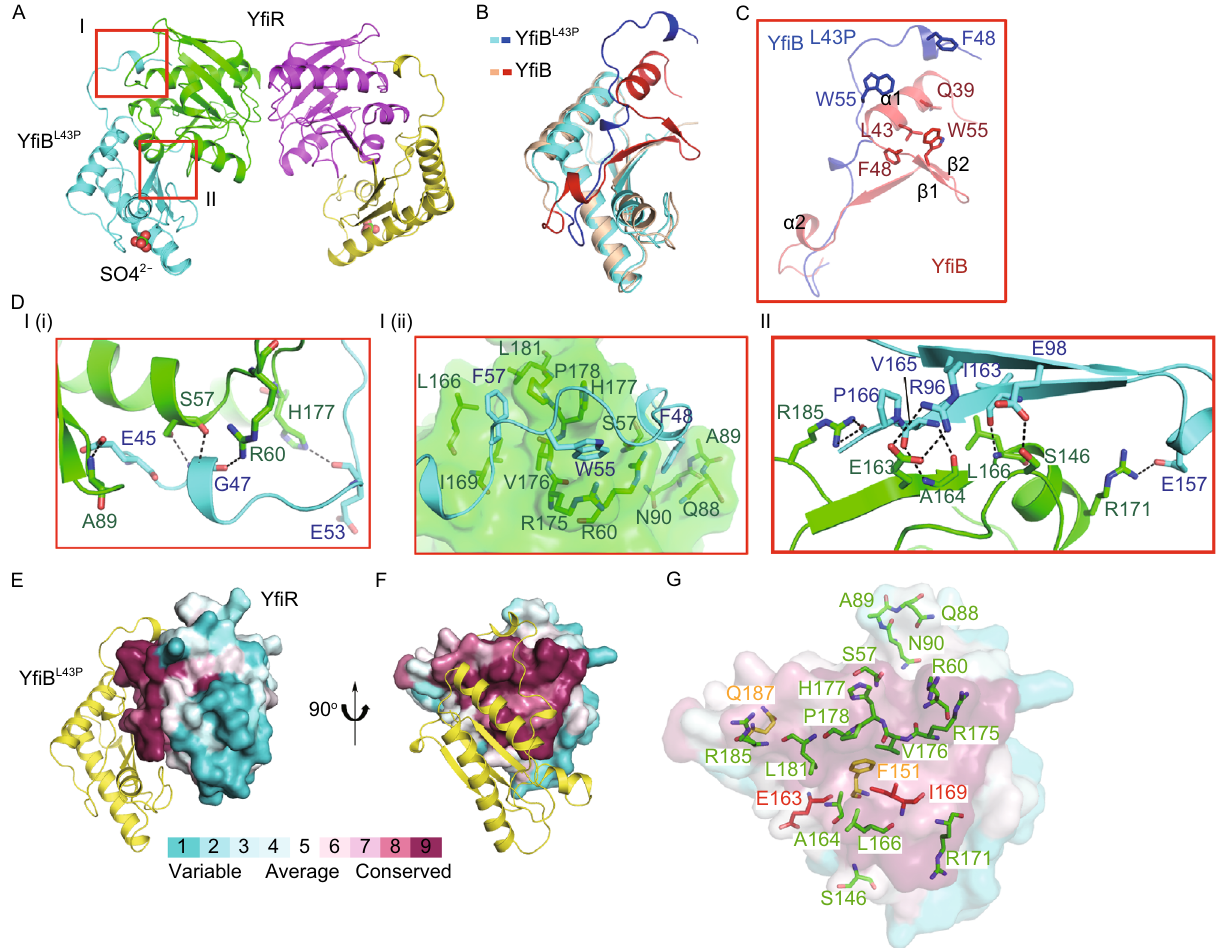
Figure 3. Overall structure of the Y fi B-Y fi R complex and the conserved surface in Y fi R. (A) The overall structure of the Y fi B- Y fi R complex. The Y fi B L43P molecules are shown in cyan and yellow. The Y fi R molecules are shown in green and magenta. Two interacting regions are highlighted by red rectangles. (B) Structural superposition of apo Y fi B and Y fi R-bound Y fi B L43P . To illustrate the differences between apo Y fi B and Y fi R-bound Y fi B L43P , the apo Y fi B is shown in pink, except residues 34 – 70 are shown in red, whereas the Y fi R-bound Y fi B L43P is shown in cyan, except residues 44 – 70 are shown in blue. (C) Close-up view of the differences between apo Y fi B and Y fi R-bound Y fi B L43P . The residues proposed to contribute to Y fi B activation are illustrated in sticks. The key residues in apo Y fi B are shown in red and those in Y fi B L43P are shown in blue. (D) Close-up views showing interactions in regions I and II. Y fi B L43P and Y fi R are shown in cyan and green, respectively. (E and F) The conserved surface in Y fi R contributes to the interaction with Y fi B. (G) The residues of Y fi R responsible for interacting with Y fi B are shown in green sticks, and the proposed Y fi N- interacting residues are shown in yellow sticks. The red sticks, which represent the Y fi B-interacting residues, are also responsible for the proposed interactions with Y fi